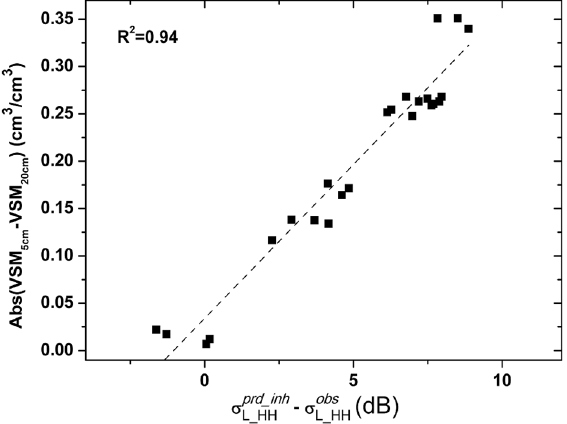
σ − σ and the absolute difference of Figure 11. Theoretical comparisons between _ prd inh obs L_HH L_HH measured soil moisture at the 5cm ( VSM 5 cm ) soil depth and an assumed frozen soil layer underneath with equivalent soil moisture at the 20 cm ( VSM 20 cm ) depth of 0.03 cm 3 /cm 3